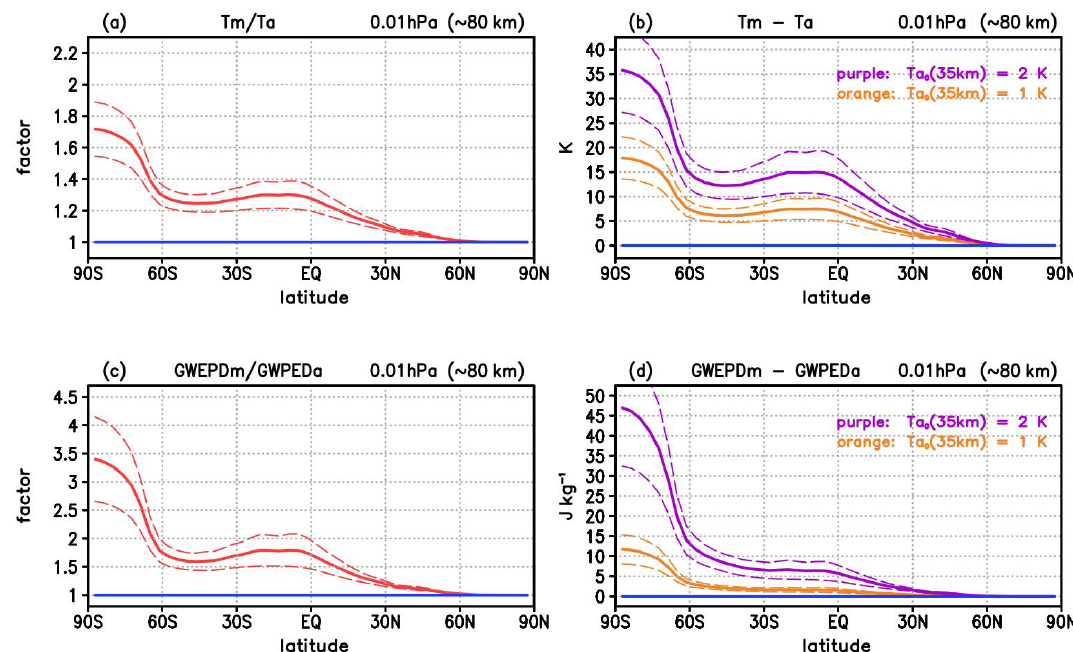
Figure 7. Similar to Fig. 6 but for both relative and absolute changes in mean values averaged over 16 representative mesoscale GW events with different horizontal and vertical wavelengths L k and L m ( L k : 200, 500, 800, and 1100km, L m : 3, 5, 7, and 9km), (a) relative change in temperature amplitude T m /T a (solid red line; dashed lines denote the standard deviation), (b) absolute change T m − T a for the case of an initial temperature perturbations T a0 of 1K (orange line) and 2K (purple line) in the middle stratosphere, (c) and (d) same as (a) and (b) but for the GWPED (i.e., for E m /E a and E m − E a